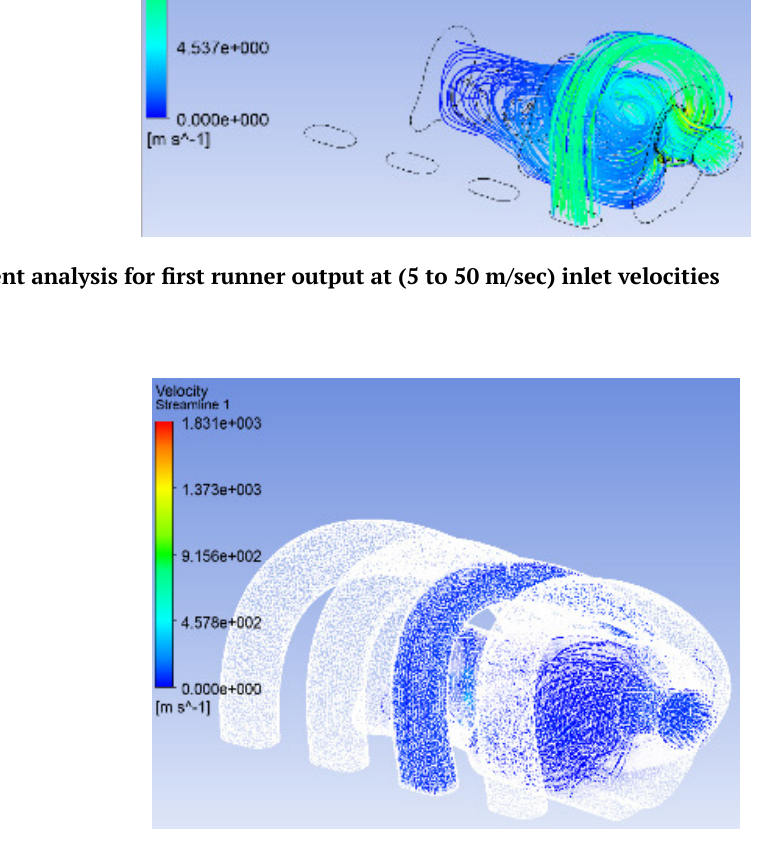
Fig. 13. Transient analysis for Second runner output at (5 to 50 m/sec) inlet